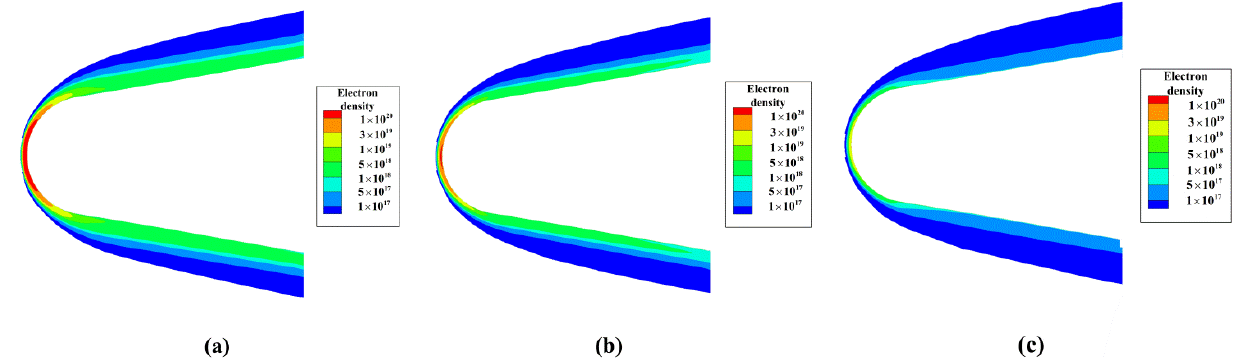
Figure 2. The electron density distribution in scenes 1, 2, and 3. ( a ) Altitude is 30 km. ( b ) Altitude is 40 km. ( c ) Altitude is 50 km.